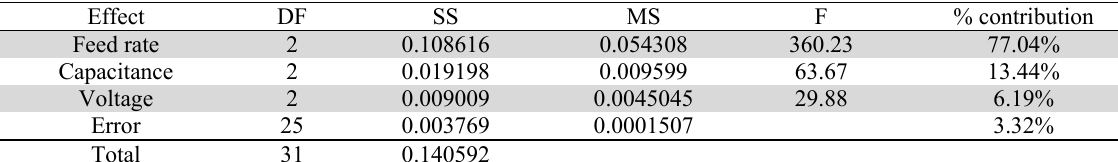
Fig. 5. Classification tree for prediction of TWR (three classes) ANOVA results for